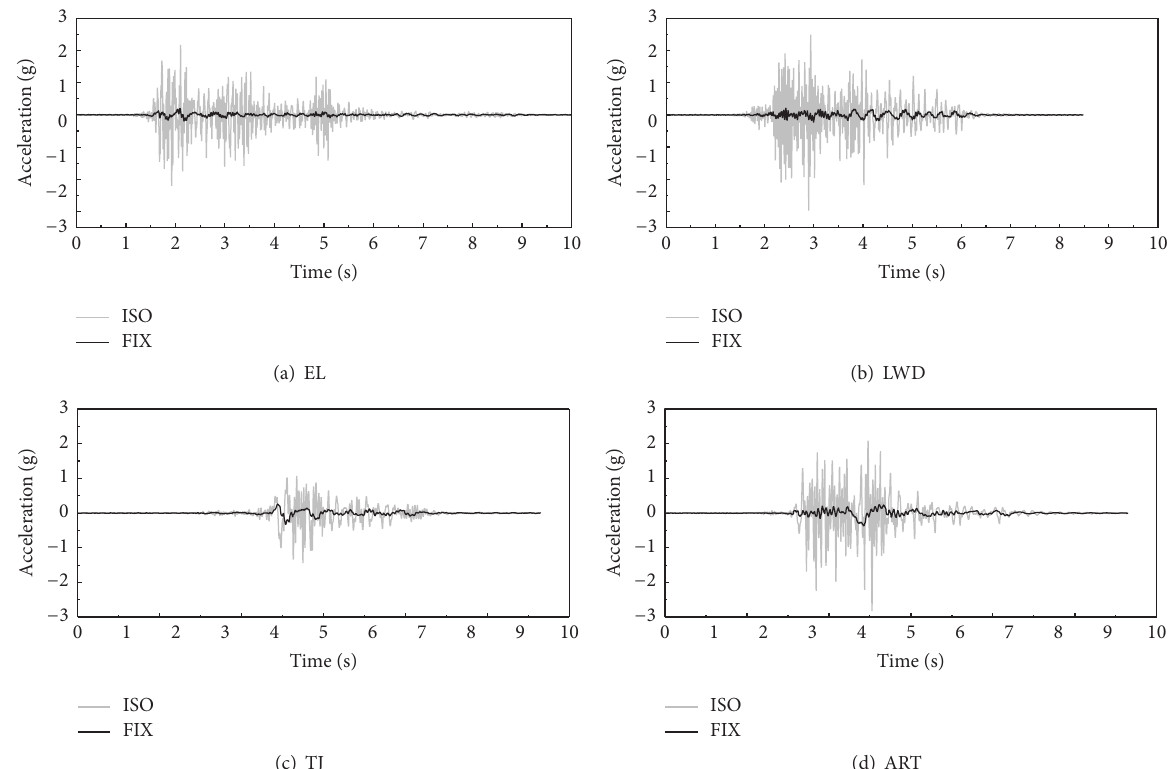
Figure 16: Comparisons on roof acceleration time history of the isolated and fixed structure under major earthquake in direction x